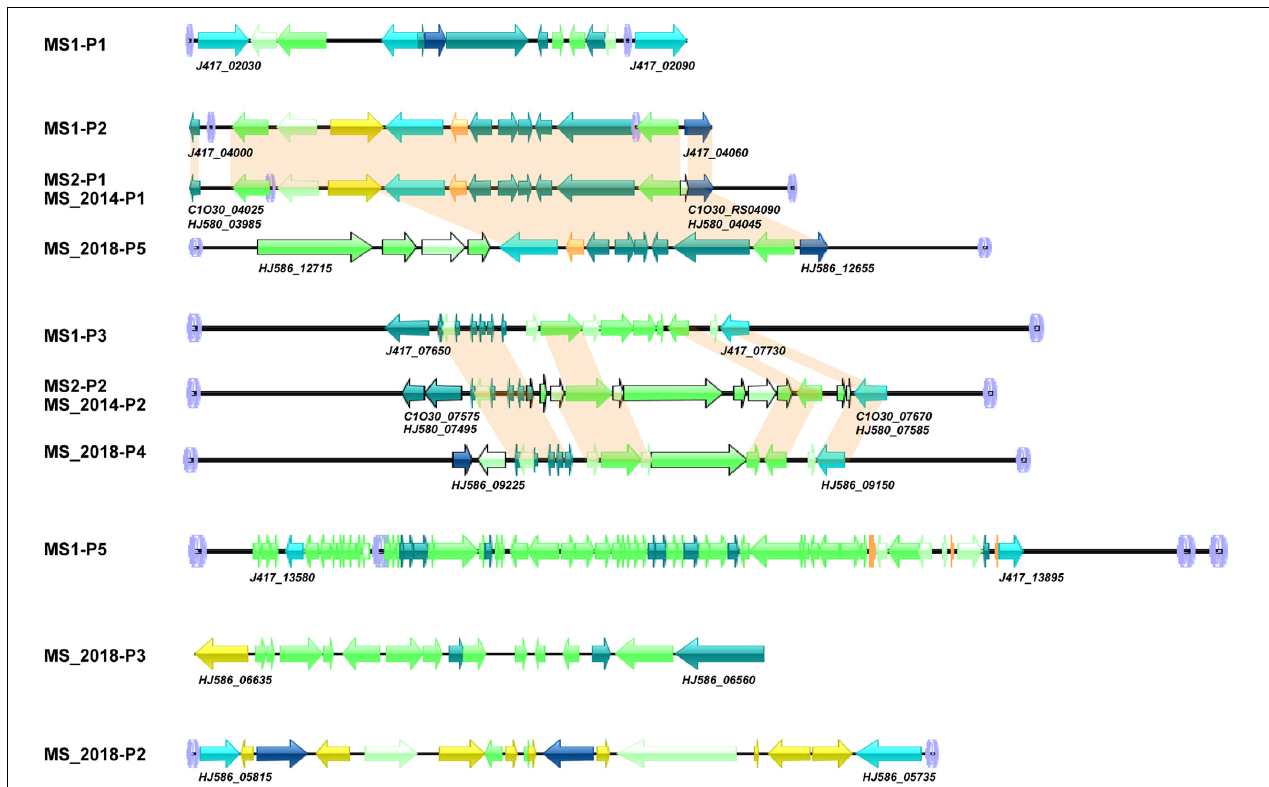
FIGURE 8 | Genomic organization of prophage gene clusters of D . zeae strains isolated from banana. Arrow position represents forward/reverse gene orientation (genes aligned with a shadow are homologous). Arrow colors indicate specific gene composition, att loci, integrases, transposases, phage-like proteins, tail shaft proteins, tRNA, other genes, hypothetical